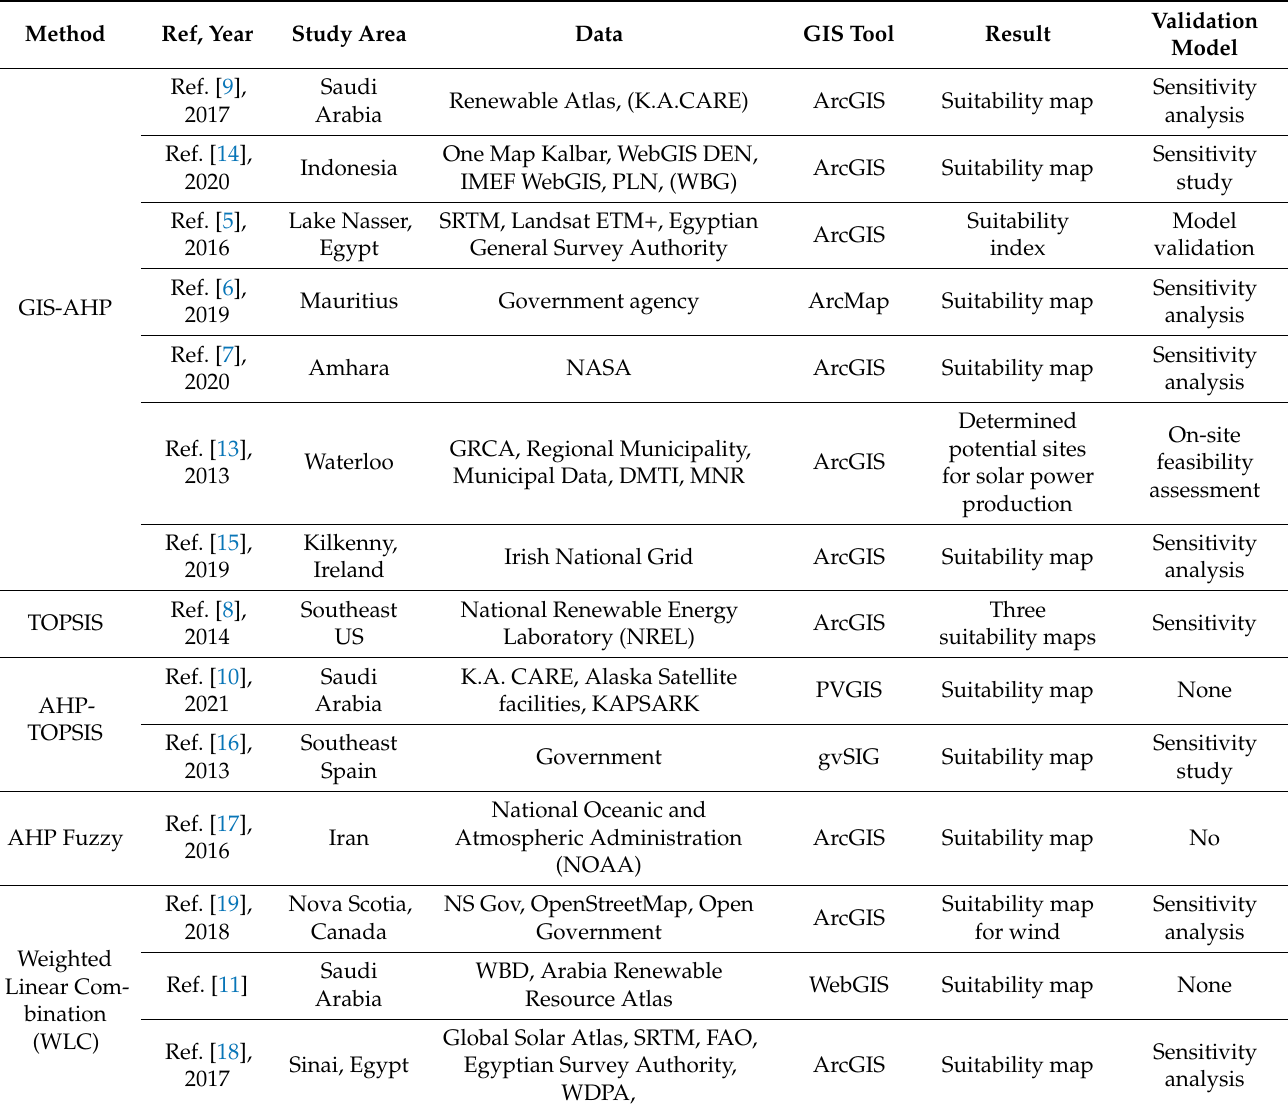
Table 1. Remote sensing and site suitability